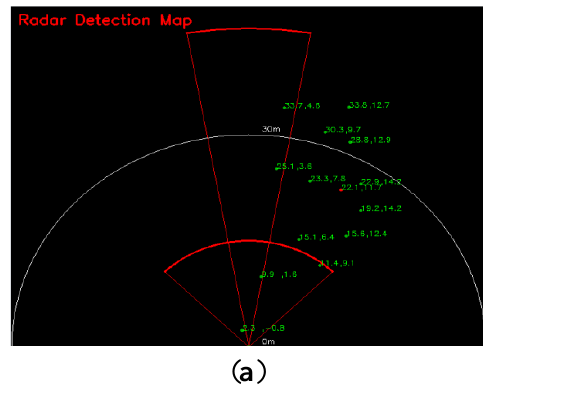
Figure 5. ( a ) MMW radar detection map on a campus road; ( b ) the fusion result corresponding to the near potential targets detected by